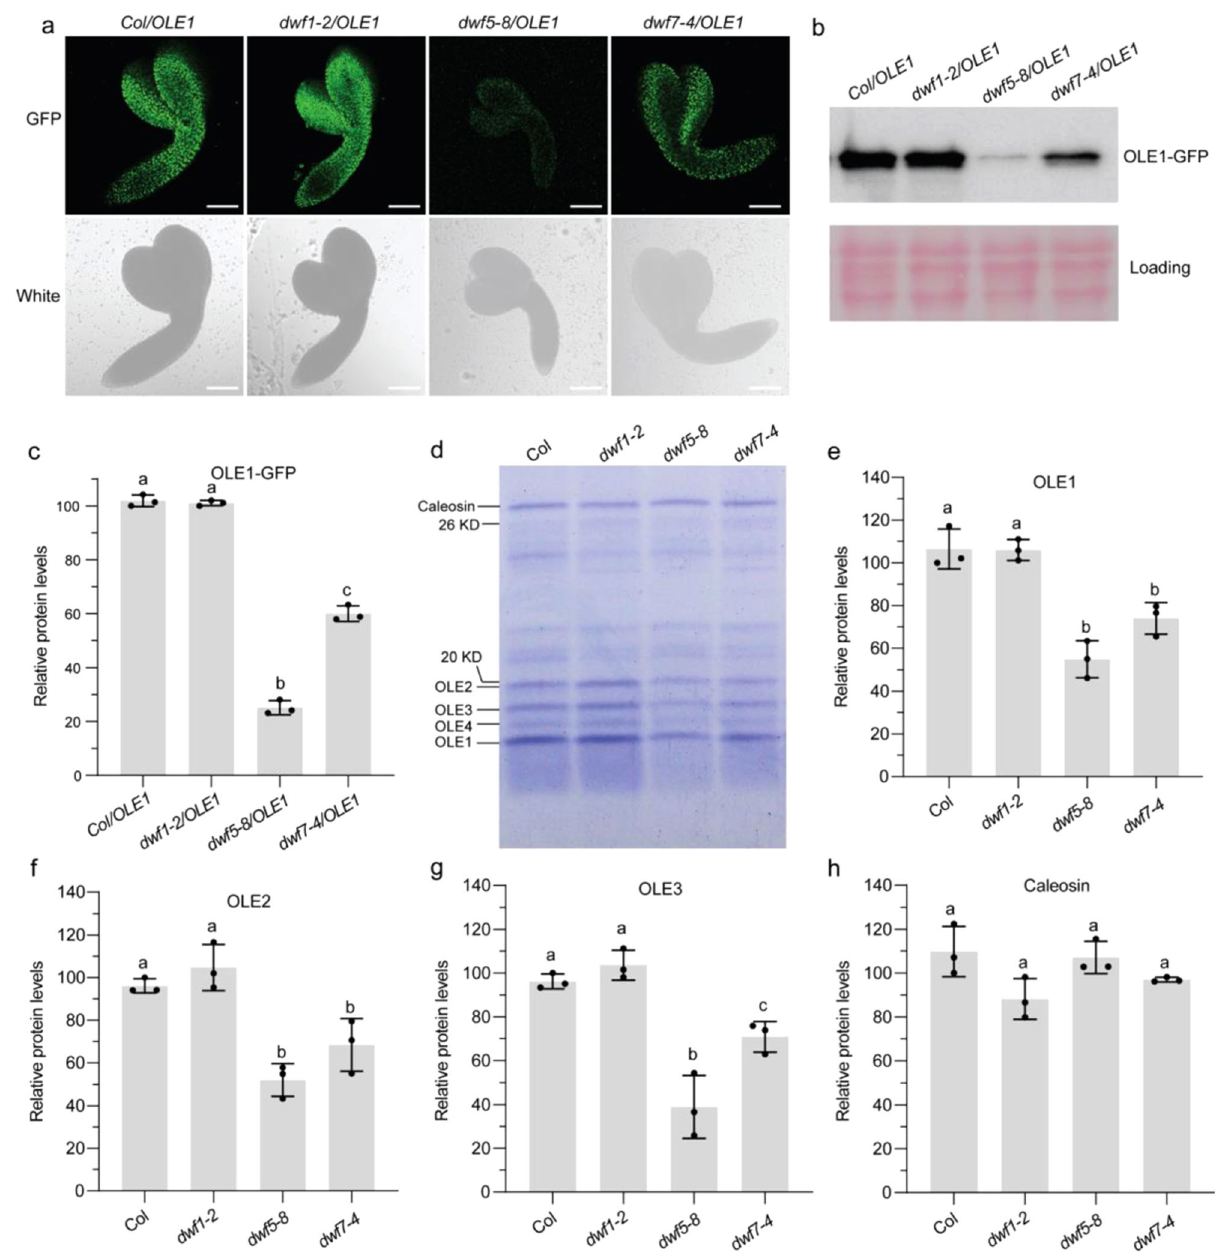
Fig. 7 Seed oleosin protein abundance is decreased in dwf5 and dwf7 mutants. a Representative images of LDs (OLE1-GFP, green) in embryos at the bent cotyledon stage. The experiment was repeated three times with similar results. Bar = 100 μ m. b Western blotting with anti-GFP antibody showing OLE1- GFP protein levels in embryos of Col/OLE1 , dwf1-2/OLE1 , dwf5-8/OLE1 , and dwf7-4/OLE1 at the bent cotyledon stage. Equal loading of proteins are shown by Ponceau S staining. c Relative OLE1-GFP protein levels quanti fi ed using Image J software. d – h , Oleosin and caleosin protein levels in seed LDs. LDs were puri fi ed from dry seeds. Proteins of LDs equivalent to 15 μ g of TAGs were subjected to SDS-PAGE with Coomassie blue staining ( d ). Relative oleosin and caleosin protein levels were quanti fi ed using ImageQuant TL software ( e – h ). In c , e , f , g, and h , data are mean ± SD. of three biological replicates. Different letters indicate signi fi cant differences at P < 0.05, as determined by one-way ANOVA with Tukey ’ s multiple comparisons